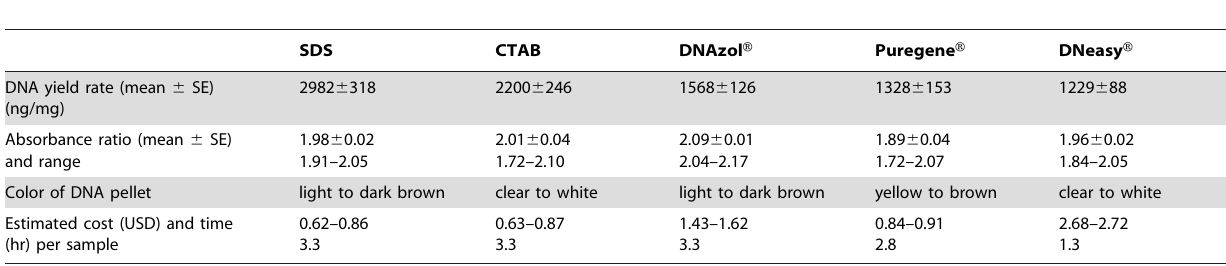
Table 1. DNA yield rate, absorbance ratio, DNA pellet color, and estimated cost and time used for one beetle extraction by five extraction